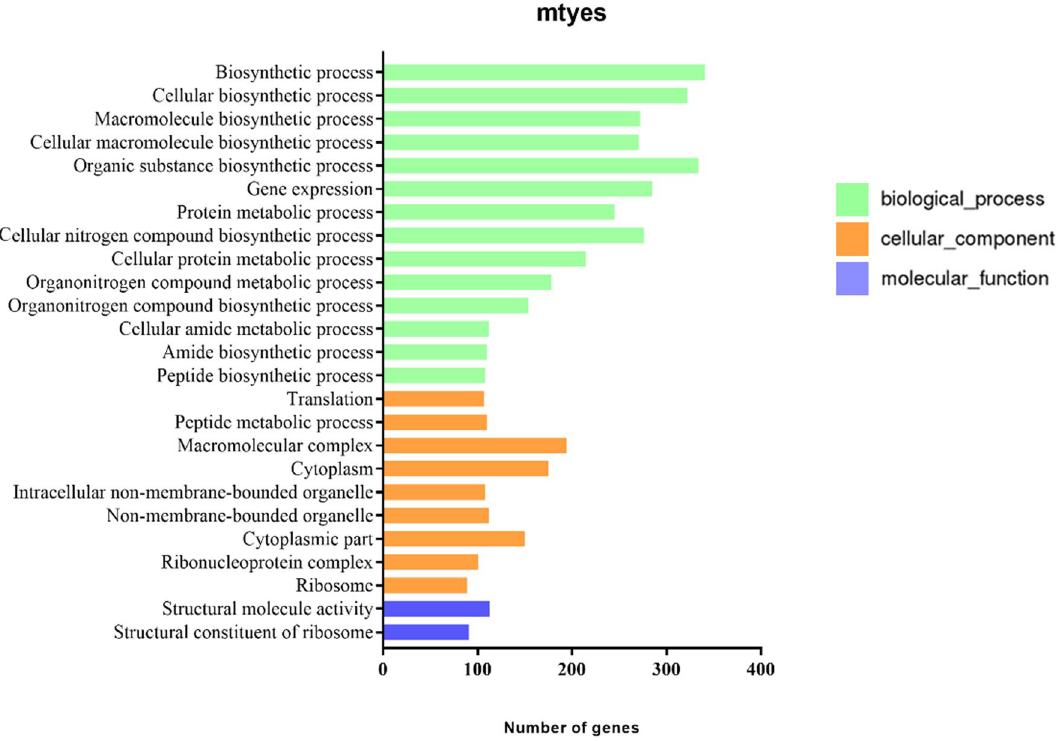
Figure 6. The most abundant gene ontologies in T-MT. In the biological process category, “biosynthetic process (GO:0009058)” and “organic substance biosynthetic process (GO:1901576)” were the most highly represented groups. For cellular component, the most-abundant groups were “macromolecular complex (GO:0032991)”. In terms of molecular function, “structural molecule activity (GO:0005198)” were overrepresented.